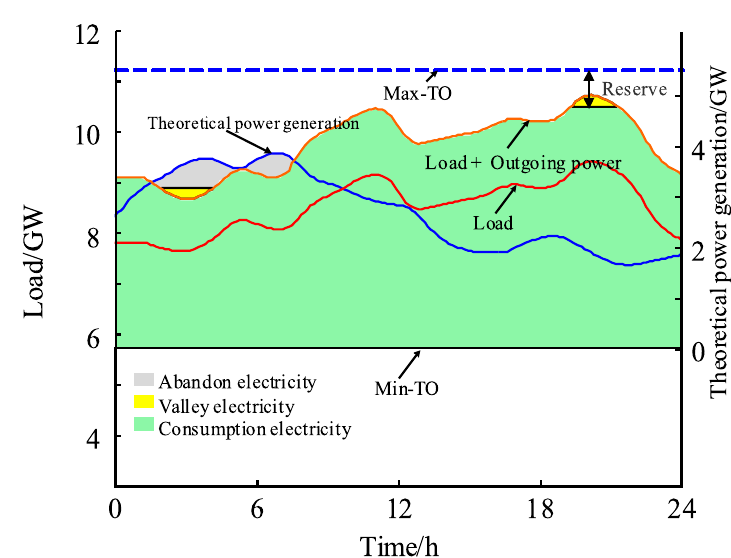
Fig. 1 Schematic diagram of renewable energy accommodation capacity